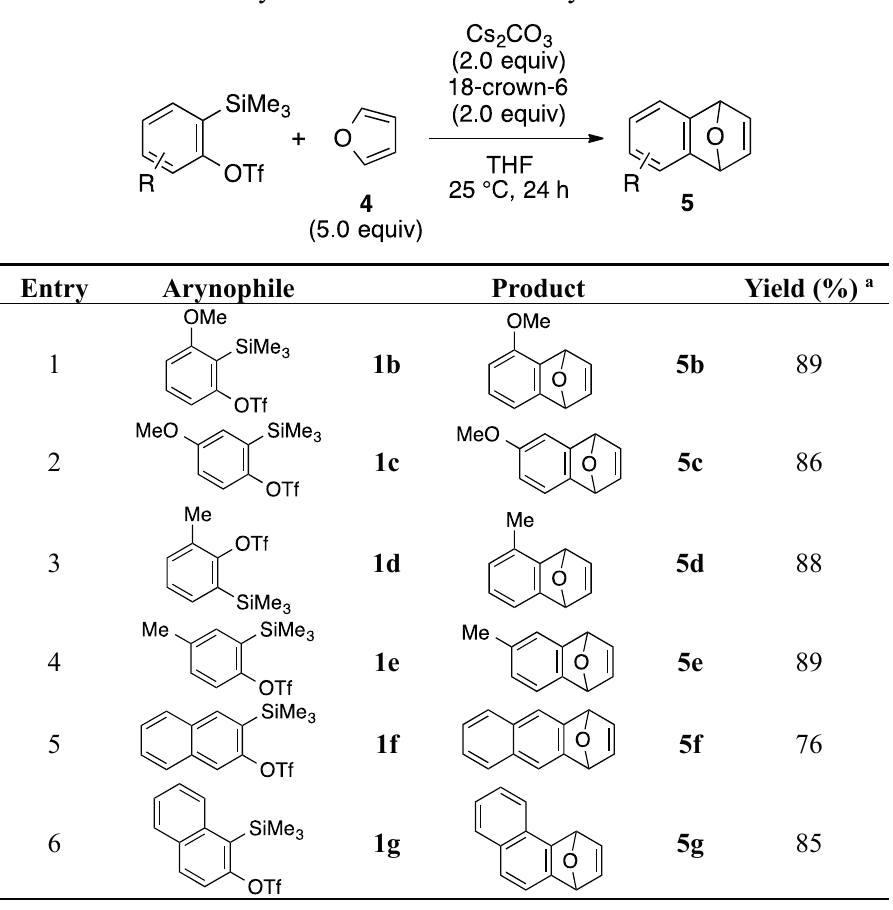
Table 3. Cycloaddition of various arynes with